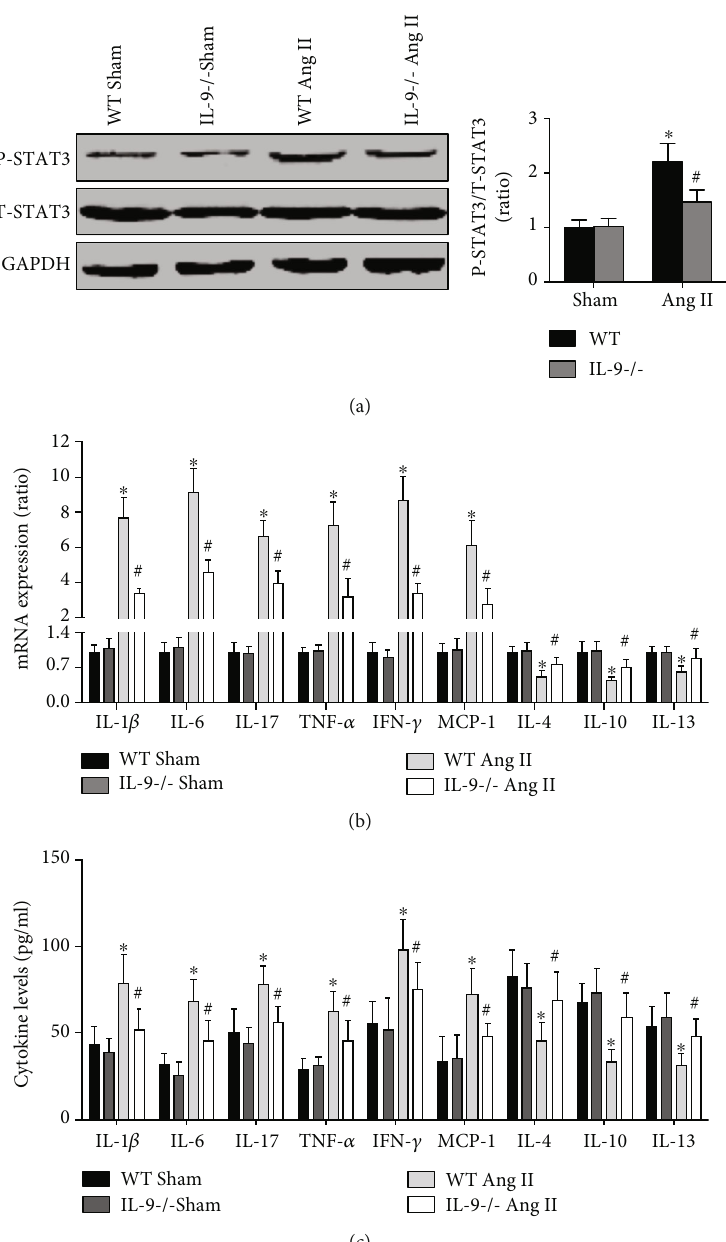
Figure 4: E ff ects of IL-9 KO on in fl ammatory response. (a) STAT3 phosphorylation for the four groups was measured. (b) The expression of aortic IL-1 β , IL-6, IL-17, TNF- α , IFN- γ , MCP-1, IL-4, IL-10, and IL-13 mRNA in each group was analyzed. (c) Serum levels of these cytokines were detected using ELISA. N = 5 in each group. ∗ p < 0 : 05 vs. the WT Sham group; # p < 0 : 05 vs. the WT Ang II